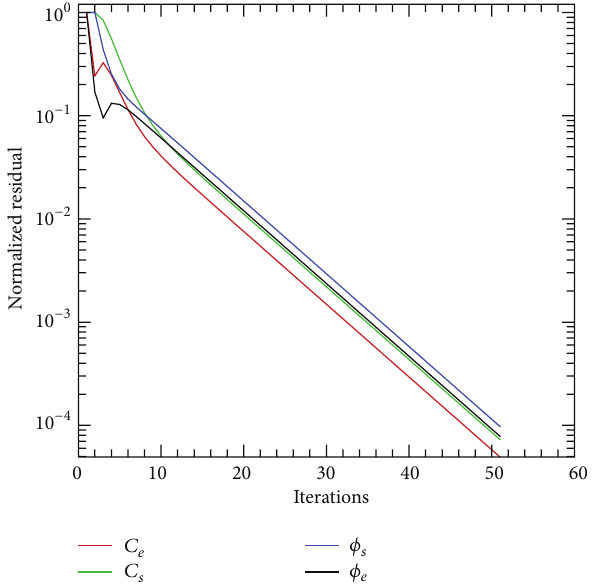
Figure 3: Convergence behavior at the tenth time step.